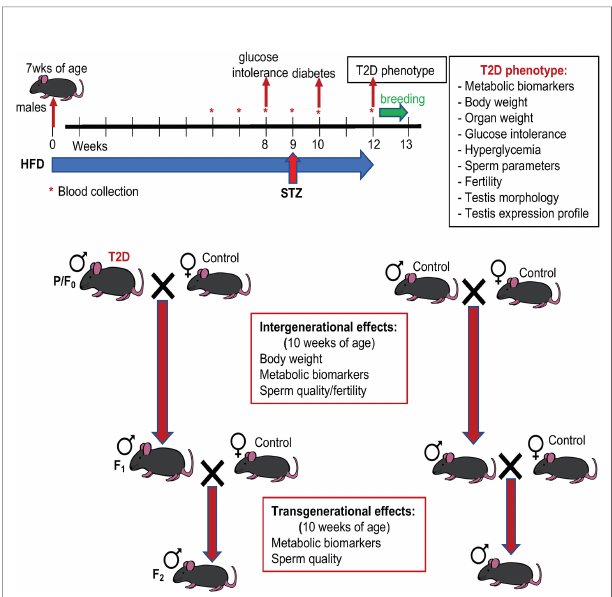
FIGURE 1 | Experimental schematics. Type 2 diabetes (T2D) was induced by a combination of high fat diet (HFD) and a low dose of streptozotocin (STZ): sexually matured males (7 weeks old) were kept on HFD for 12 weeks before mating and injected with STZ at week 9 of the HFD experiment. T2D males and standard diet (control) fed males (parental generation, P/F 0 ) were mated with standard diet fed females. After one week mating pairs were separated, males were killed, and tissues were collected for further analyses. The F 1 male offspring were mated at 9 weeks of age, after one week mating pairs were separated. F 1 males were killed, and analyses were performed at 10 weeks of age. Effects of diabetic paternal environment was also evaluated in the second (F 2 ) male offspring generation at 10 weeks of age. Both F 1 and